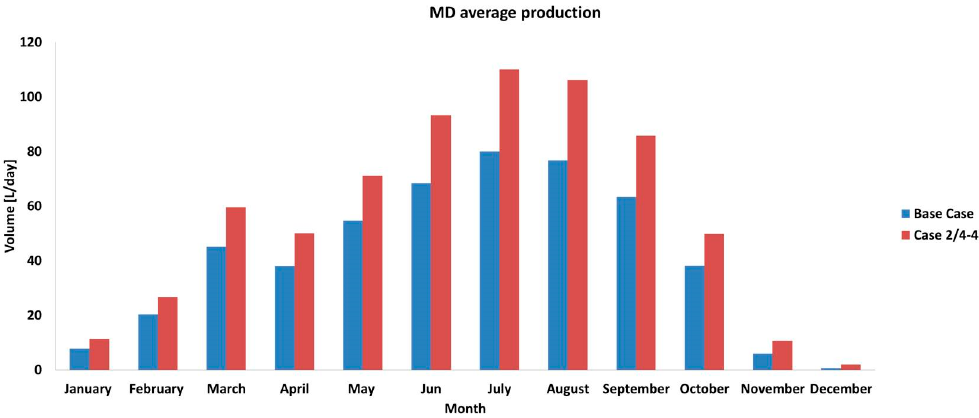
Figure 15. MD average production per month.